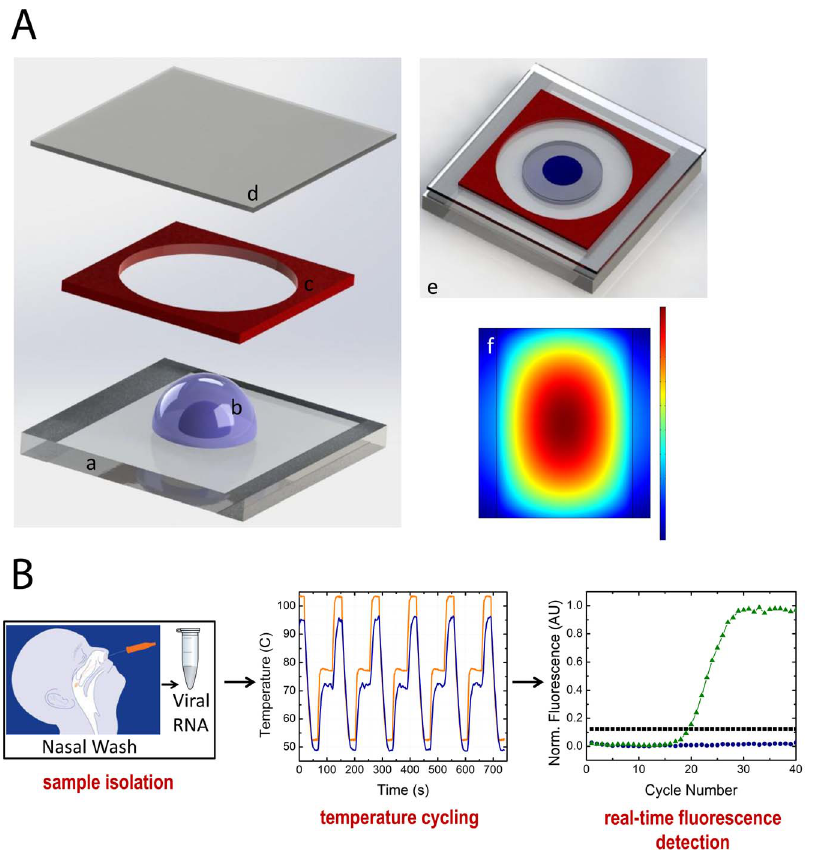
Figure 1. Droplet sandwich platform. a: Drawings of platform: 3D drawing of the droplet sandwich platform displaying the ITO coated glass (a) with a compound droplet (b) surrounded by a spacer (c) and covered with a coverslip (d), which is fully assembled to sandwich the compound droplet in a reaction chamber (e). The ITO surface heats radially, as displayed the modeled heating profile for the ITO glass when 15 V is applied to the resistive surface as generated by COMSOL Multiphysics (f). The dimension of the slide is 40 mm 6 40 mm and the compound droplet is approximately 2.8 mm in diameter. b: Workflow and representative data: Sample isolation is done from nasopharygeal swabs and the rtRT-PCR mix is transferred to the droplet sandwich platform for thermal cycling. Temperature cycling occurs at the center of the radial profile as displayed by the plot where the black line represents the controlled surface temperature and the red line is the calibrated droplet temperature. Fluorescence is collected in real-time during the extension phase of PCR, with DNA amplification of positive samples displayed in green, negative samples with no change over time in blue and calculated threshold in black.